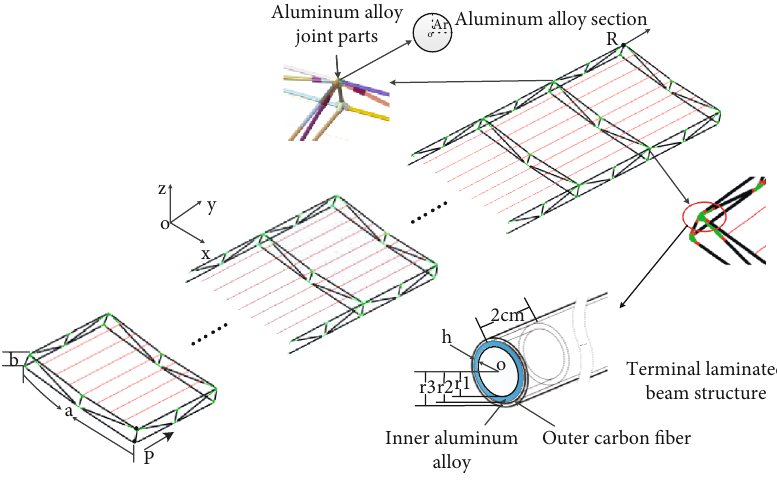
Figure 7: Structural details of the modular space structure.